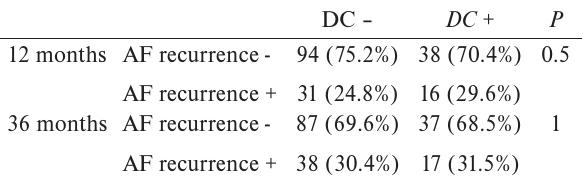
Table 1. The difference in short-term and long-term outcome in patients with and without dormant conduction.